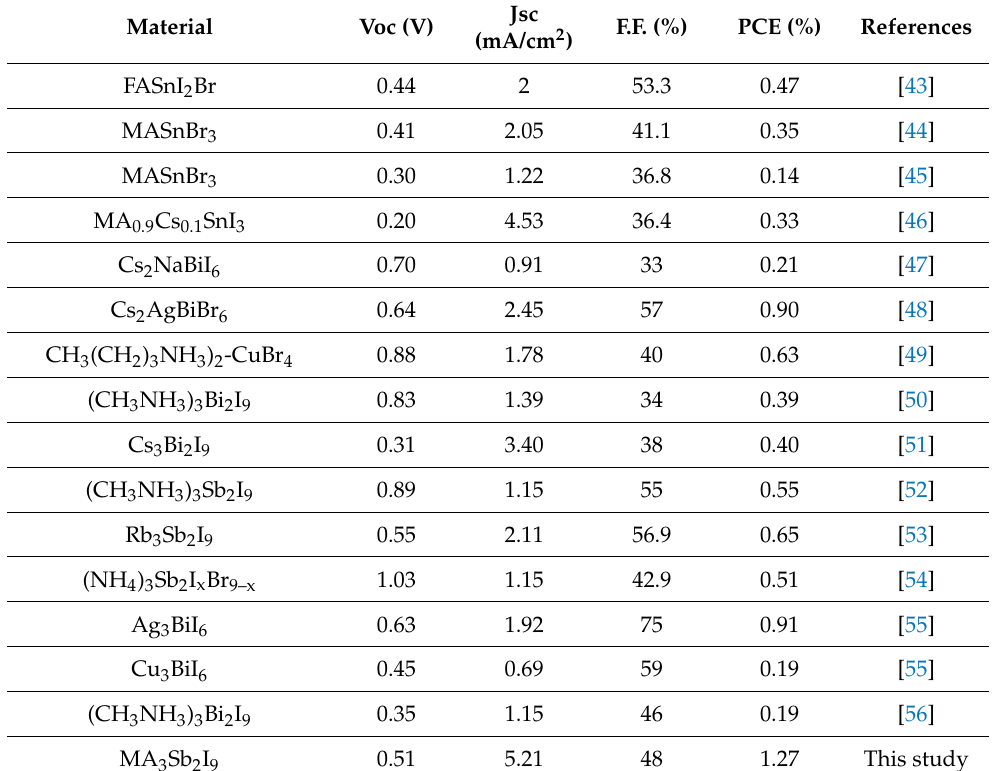
Table 2. Comparison of the Voc, Jsc, F.F., and PCE of the developed Pb 2+ free based Pb 2+ free PSCs with the recently published